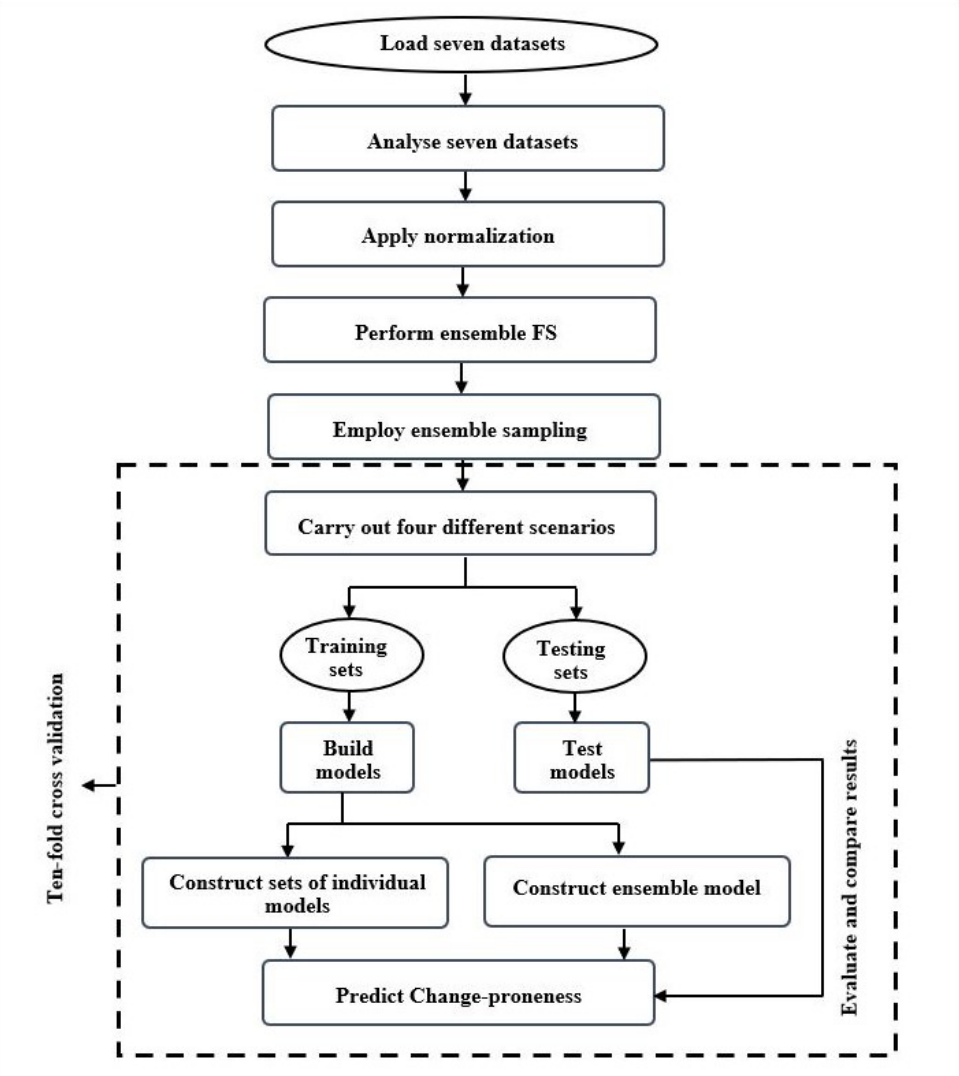
Figure 1. Framework of the research